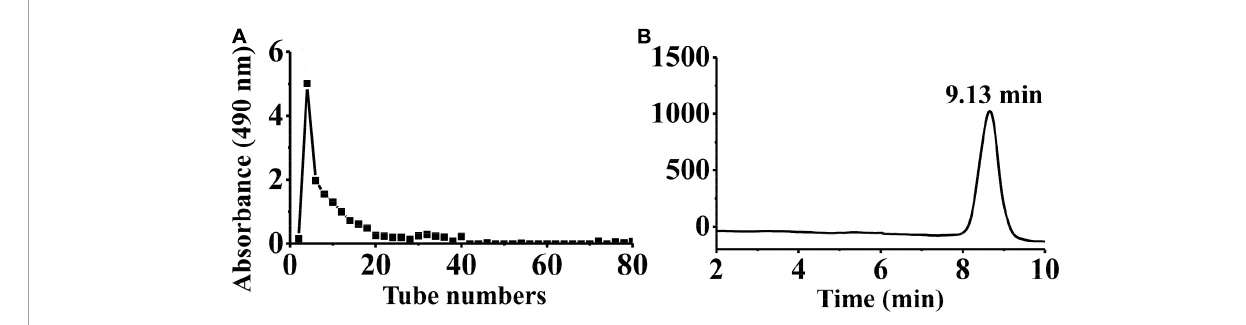
FIGURE1 Physicochemical property analysis of PKP2-1. (A) The SEC profiles for PKP2 elution; (B) The HPGPC analysis for PKP2-1.